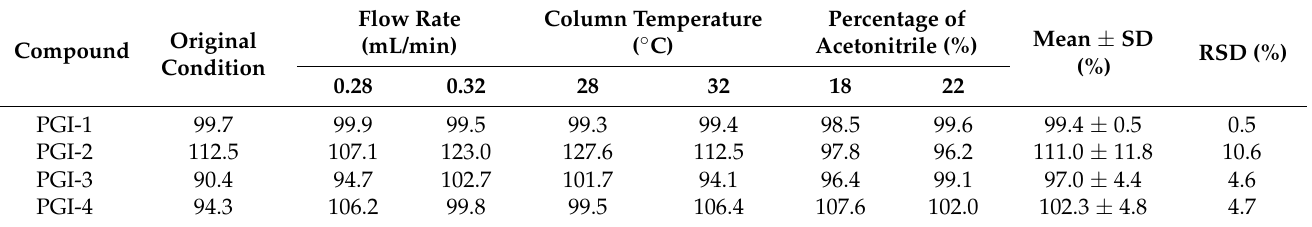
Table 4. Robustness study for the recovery of the four